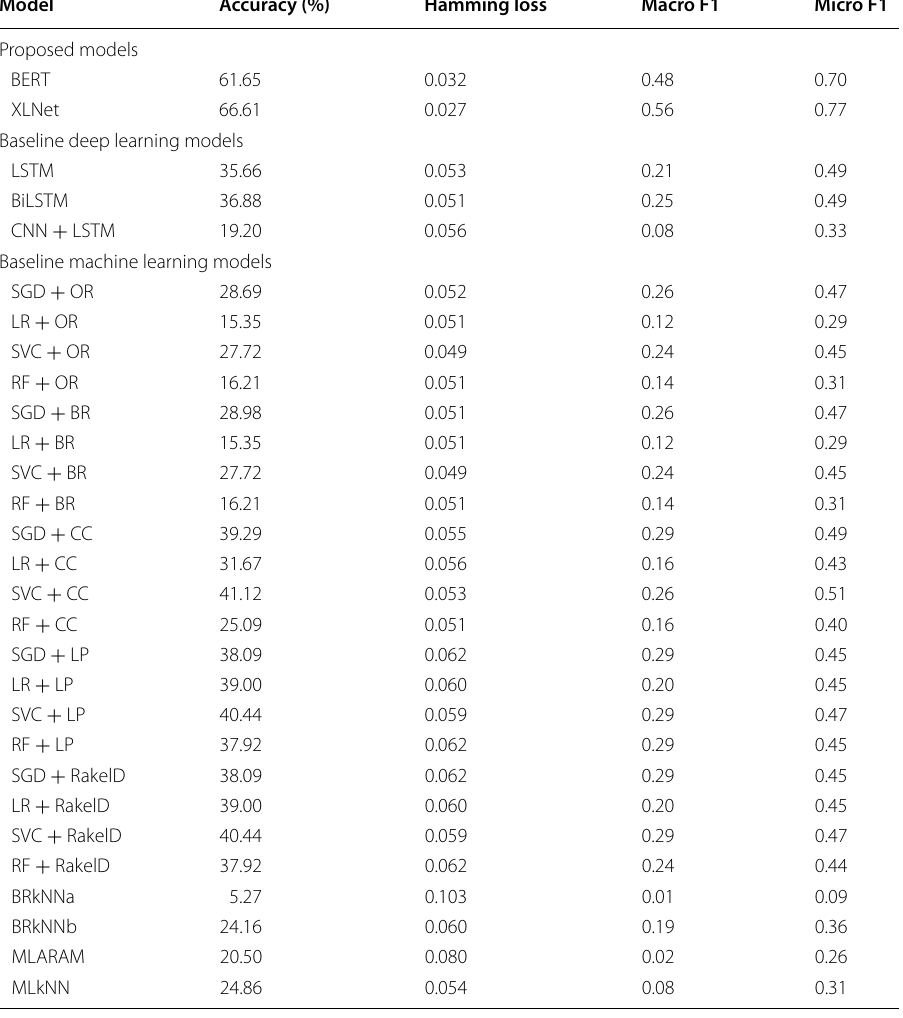
Table 8 Experiment results of Yelp